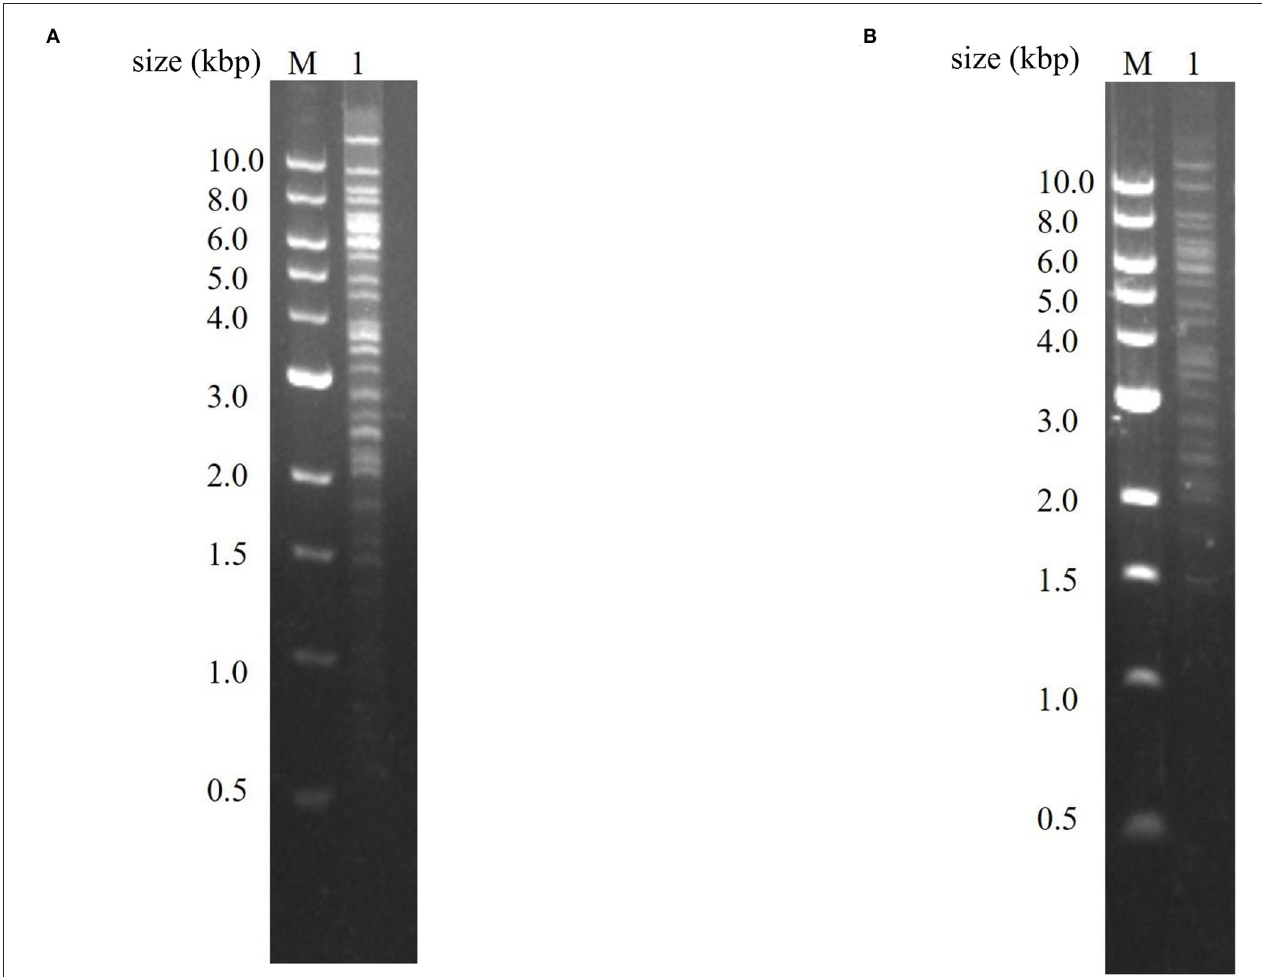
FIGURE 2 | Identification of recombinant plasmids pBeloBAC11-PRV-SARS-CoV-2-S and plasmid pBeloBAC11-PRV-SARS-CoV-N. (A) Identification of plasmid pBeloBAC11-PRV-SARS-CoV-2-S. Lane 1 was the PCR product of recombinant plasmid pBeloBAC11-PRV-SARS-CoV-2-S. (B) Identification of plasmid pBeloBAC11-PRV-SARS-CoV-2-N. Lane 1 was the PCR product of recombinant plasmid pBeloBAC11-PRV-SARS-CoV-2-N. M was DL10000 DNA Marker (Takara,